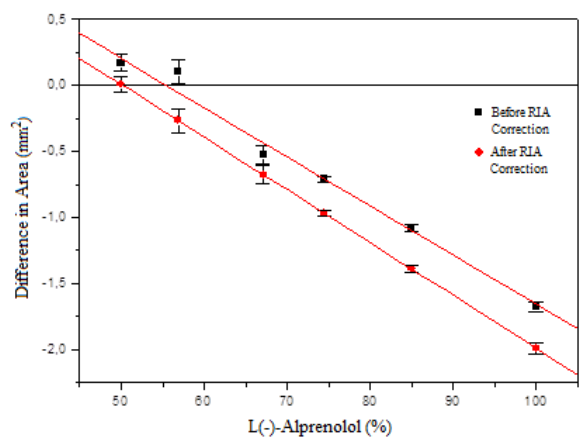
Figure 5: Achiral calibration plots before and after RIA corrections, plotting the difference in polarimetric signal peak area as a function of L(-)-Alprenolol percentage.